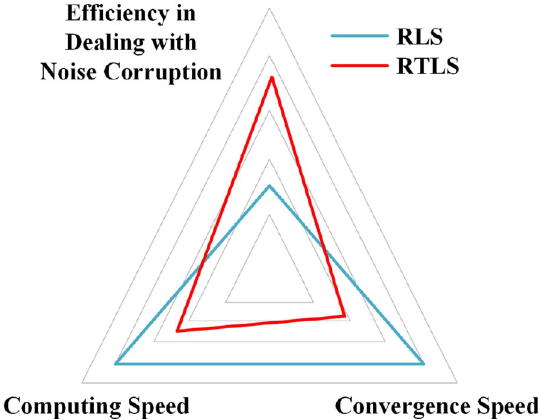
Figure 4 Performance comparison between RLS and RTLS